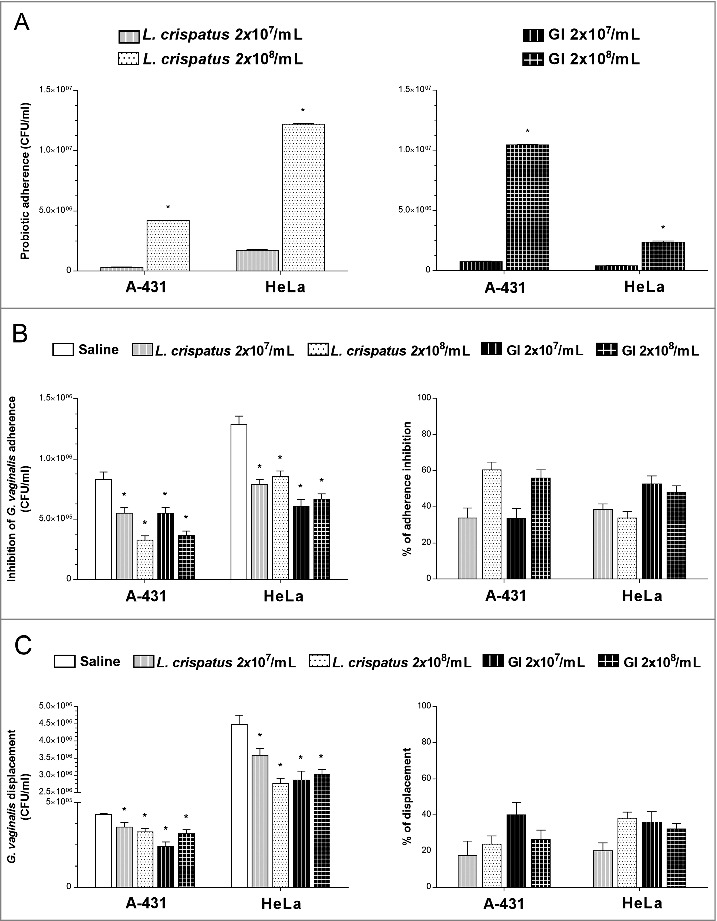
Effect of GI treatment on G. vaginalis adherence to vaginal (A-431) and cervix (HeLa) epithelial cells. (A) Adhesion of L. crispatus or GI to A-431 and to HeLa cell lines. L. crispatus or GI (both 2 × 107/ml or 2 × 108/ml) were added to monolayer of A-431 or HeLa cells for 4 h at 37°C in anaerobic conditions. After incubation, cells were washed 2 times and microorganisms adhered were quantified as number of CFU/ml. Data are the mean ± SEM from 2 independent experiments. *p < 0.05, 2 × 108/ml (L. crispatus or GI) vs 2 × 107/ml (L. crispatus or GI). (B) Interference of L. crispatus or GI on G. vaginalis initial adhesion onto A-431 and HeLa cell lines. Two inocula (2 × 107/ml or 2 × 108/ml) of L. crispatus or GI were pre-adhered to epithelial cells, as above described, and subsequently G. vaginalis (2 × 108/ml) has been added to the co-culture for 30 min at 37°C in anaerobic conditions. G. vaginalis adhered were quantified as number of CFU/ml. *p < 0.05 L. crispatus or GI vs Saline treatment. Percentage adherence inhibition was quantified in respect to Saline. (C) Reduction of G. vaginalis adherent to epithelial cells. G. vaginalis (2 × 108/ml) was incubated with the monolayers for 30 min at 37°C in anaerobic conditions. Then, non-adherent bacteria were removed by washing and probiotics (2 × 107/ml or 2 × 108/ml) were added to co-cultures for 30 min at 37°C in anaerobic conditions. G. vaginalis displacement was expressed as CFU/ml as described in Material and Methods. *p < 0.05 L. crispatus or GI vs Saline treatment.